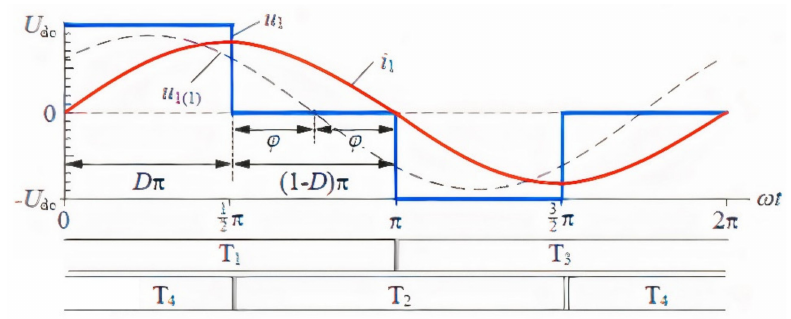
Figure 18. Dual (self-sustained) Control of IPT